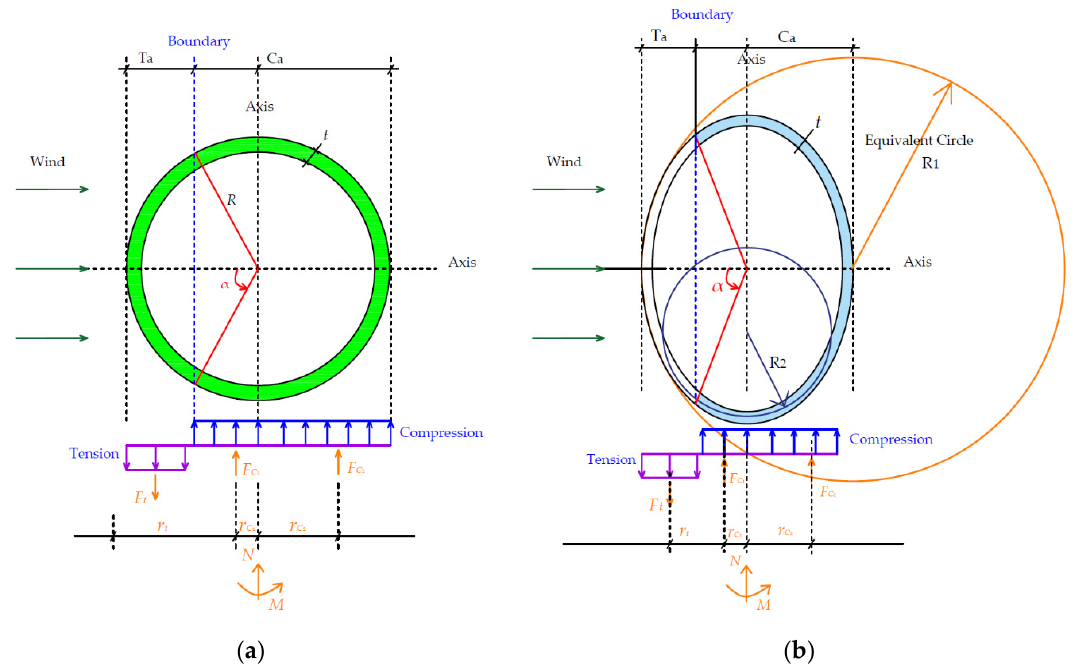
Figure 6c identifies an equivalent radius shell (cid:1844) (cid:2869) . This, together with Figure 4 and Equation (33), enables the formulation of the local buckling equation linked to the minimum curvature strip. Figure 7. Loading conditions of undeformed and ovalised shell cross sections, ( a ) tubular shell cross section without ovalisation and ( b ) ovalised tubular shell cross section.